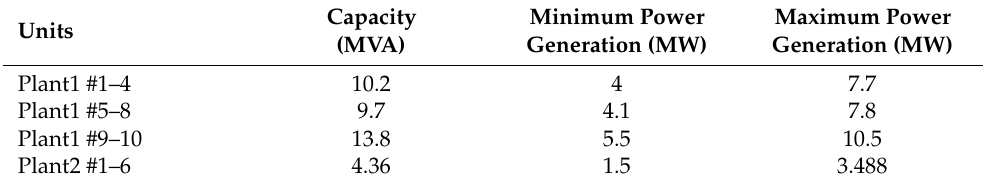
Table 3. Diesel generator cost factor and startup cost.